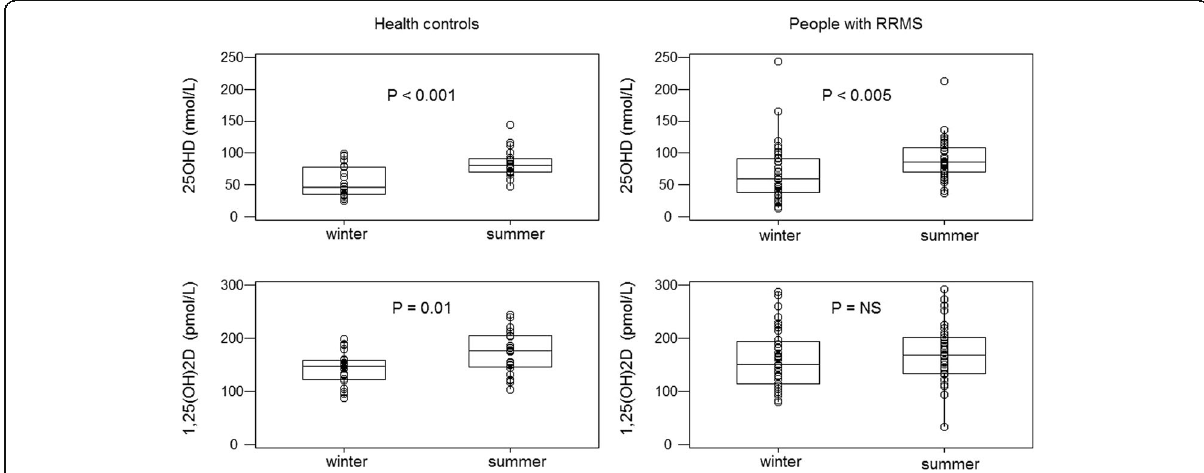
Fig. 1 Serum 25OHD and serum 1,25(OH) 2 D Individual values (open circles), cohort medians and interquartile ranges (boxes) are plotted for those subjects who had both winter and summer measurement of serum 1,25(OH) 2 D. Serum 25OHD increased from winter to summer in both HC and RRMS subjects. However, only HC demonstrated a significant seasonal rise in serum 1,25(OH) 2